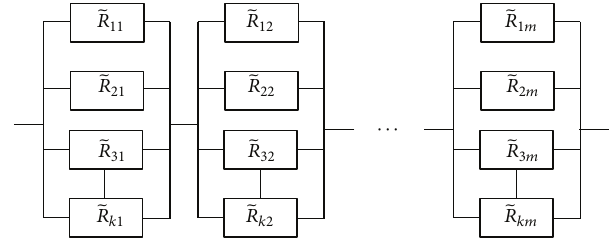
Figure 3: Fuzzy series-parallel system.